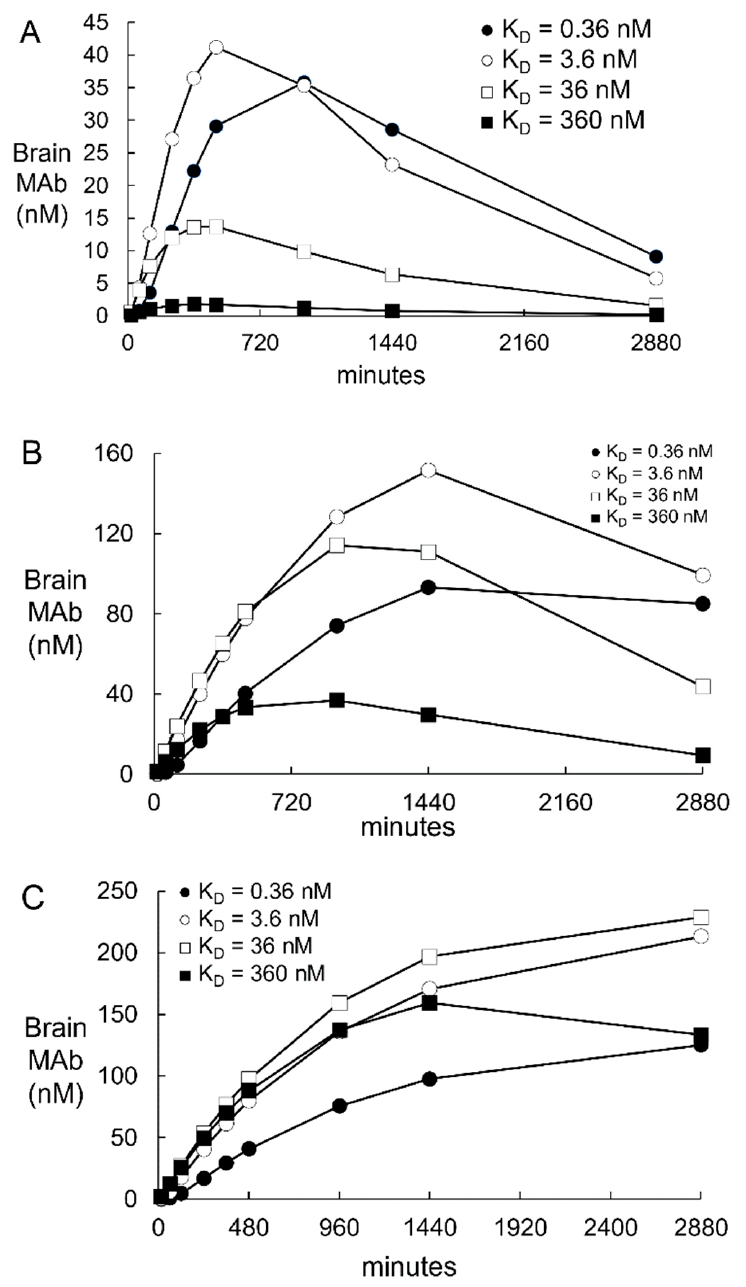
Figure 3. Predicted brain TfRMAb concentrations [variable H ( t ), Figure 1] are plotted from t = 0 to t = 2880 min after an IV administration of 0.2 mg/kg (panel A ), 3 mg/kg (panel B ), or 30 mg/kg (panel C ) of the TfRMAb in the monkey. Simulations were performed for a high affinity TfRMAb (K D = 0.36–3.6 nM), a moderate affinity TfRMAb (K D = 36 nM), and low affinity TfRMAb (K D = 360 nM). The plasma input function, A ( t ), was computed from A 0 and α values reported previously for each of these injection doses [15]. The parameter values used for these simulations are those derived from simulation 1 (Figure 2, Table Table 4. TfRMAb K D , binding kinetics, and brain TfRMAb AUC.